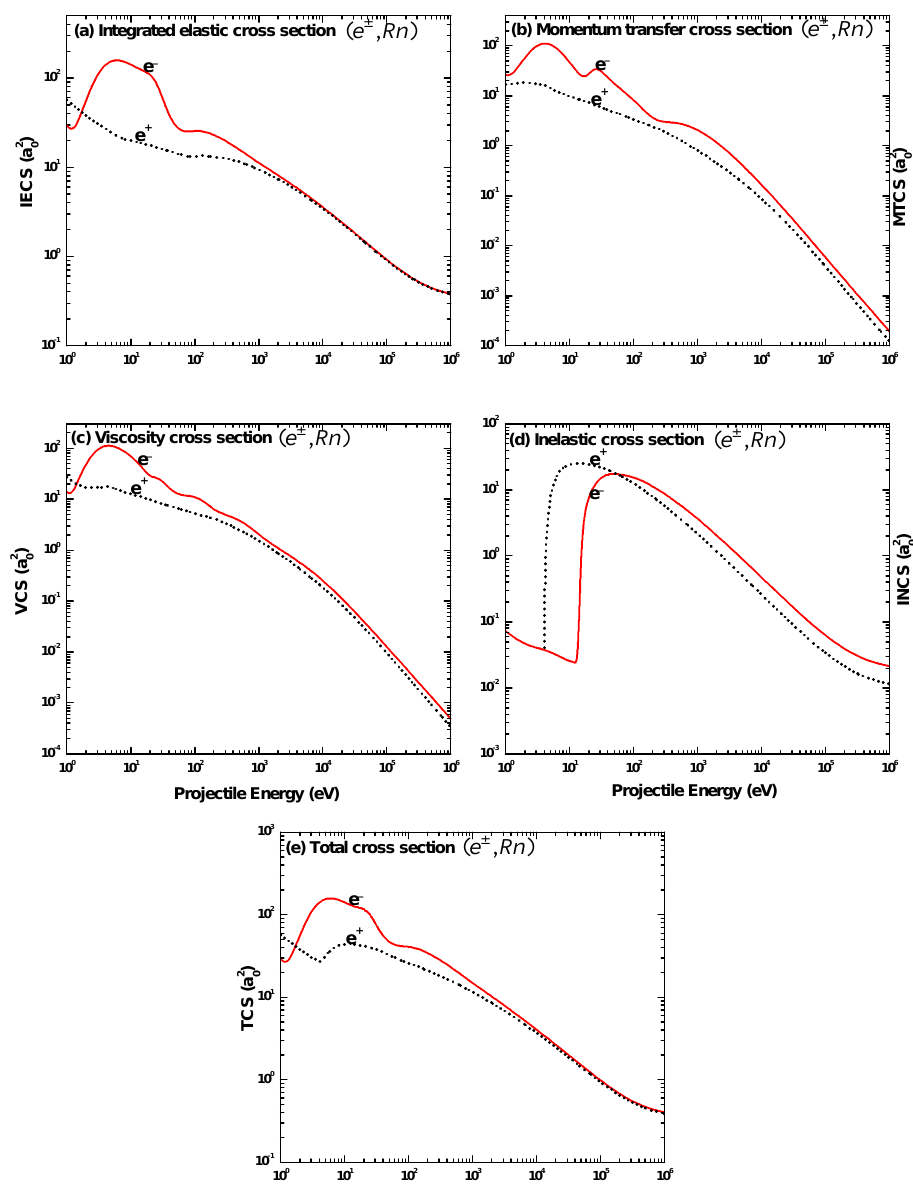
Figure 35. Comparison of IECS, MTCS, VCS, INCS and TCS results for the collisions of electrons and positrons from neutral radon at the scattering angle of 90 ◦